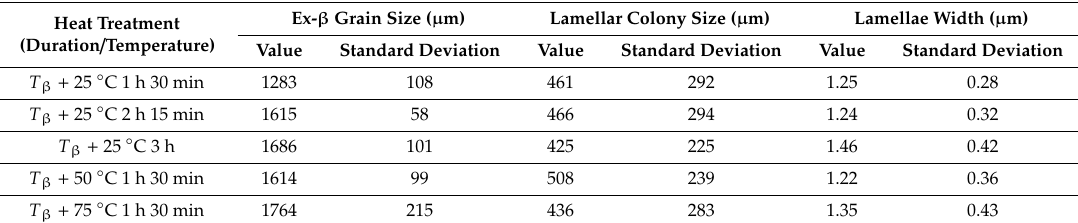
Table 2. Lamellar microstructure